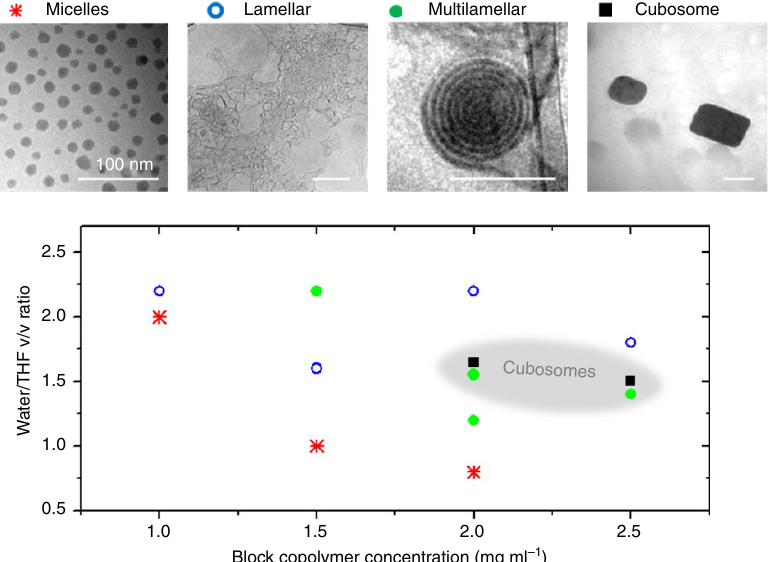
Figure 2 | Morphologies of self-assembled particles. Morphology formation of PAA 45 - b -PIL 23 in water/THF mixtures as a function of block copolymer concentration and solvent composition. Four regions of interest were observed—micelles, lamellae, multilamellar vesicles and cubic particles. The regions with overlapped colours are metastable. The scale bar in TEM micrographs is 100nm.